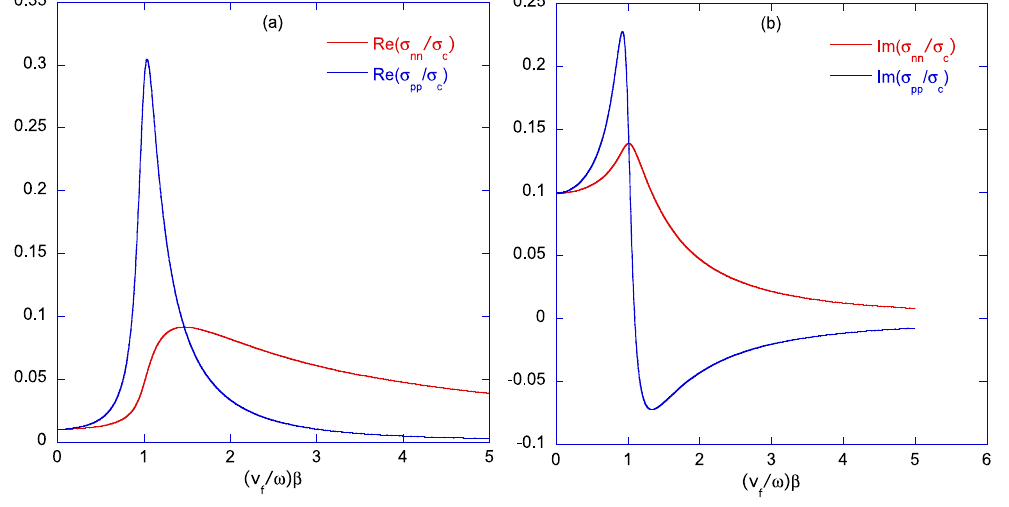
Figure 8. Real ( a ) and imaginary ( b ) parts of ),( / ω ) β for ν / ω = 0.1. vs . ( ν F